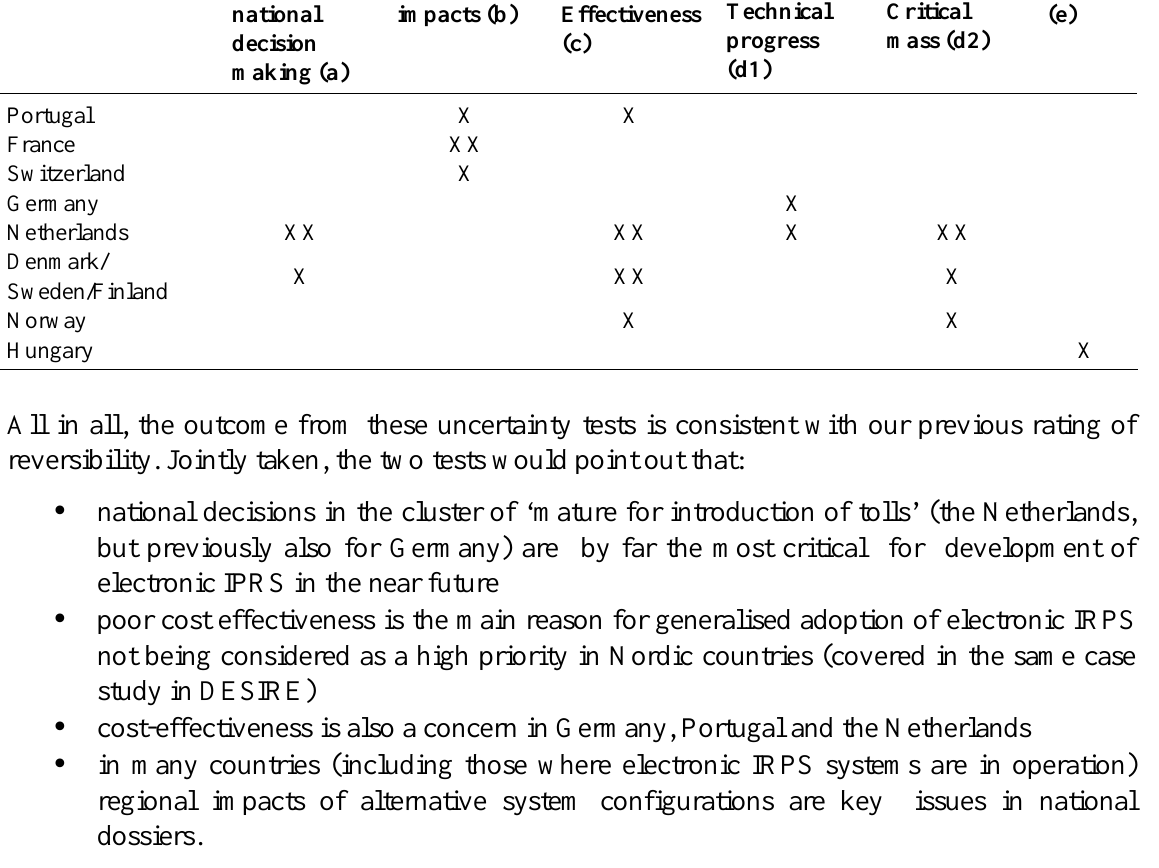
Uncertainty on technology Barriers